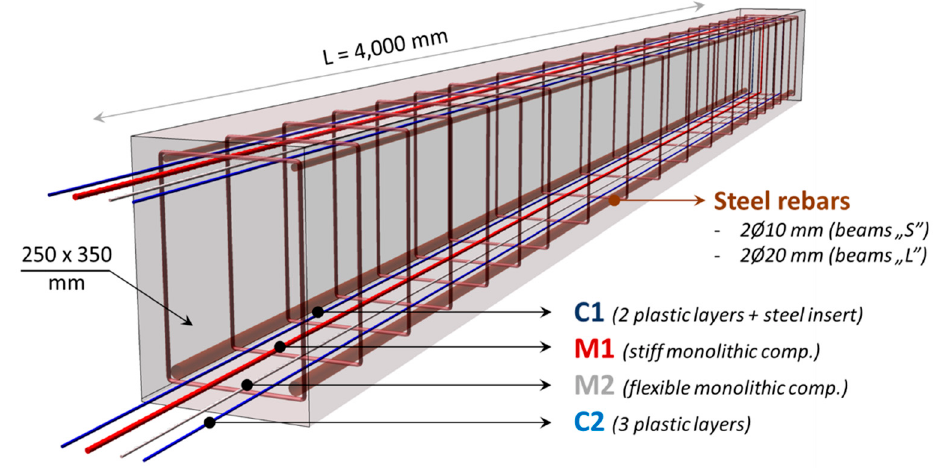
Figure 15. Spatial visualisation of the concrete beams equipped with embedded DFOS tools.